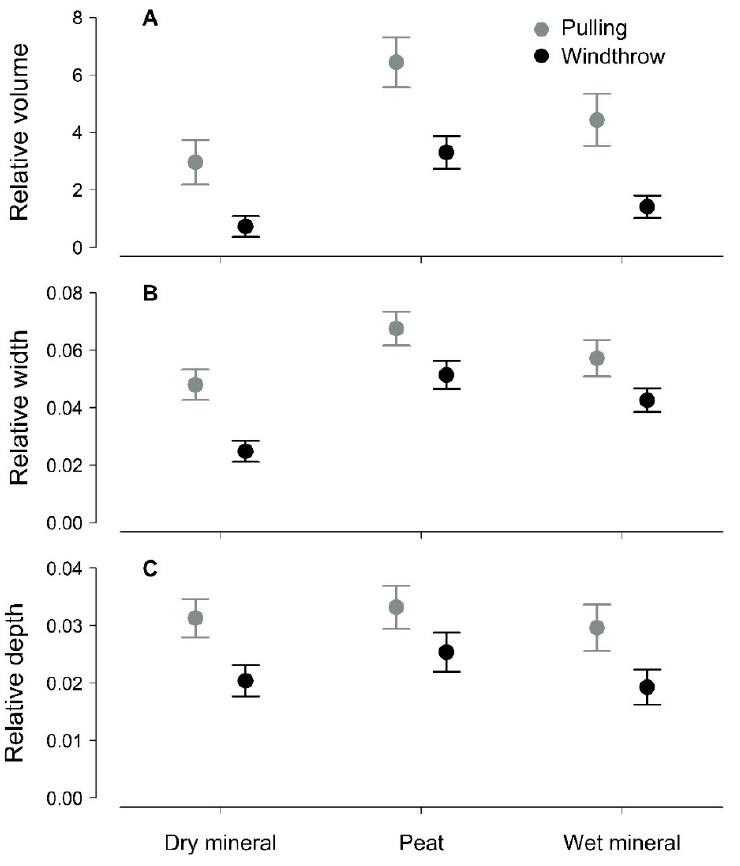
Figure 1. Estimated marginal mean ( ± 95% standard error) volume ( A ) (expressed per stemwood volume), depth ( B ), and width ( C ) (expressed per stem diameter at breast height) of soil–root plates of pulled and windthrown trees of Eastern Baltic silver birch on freely draining mineral, drained deep peat, and periodically waterlogged mineral